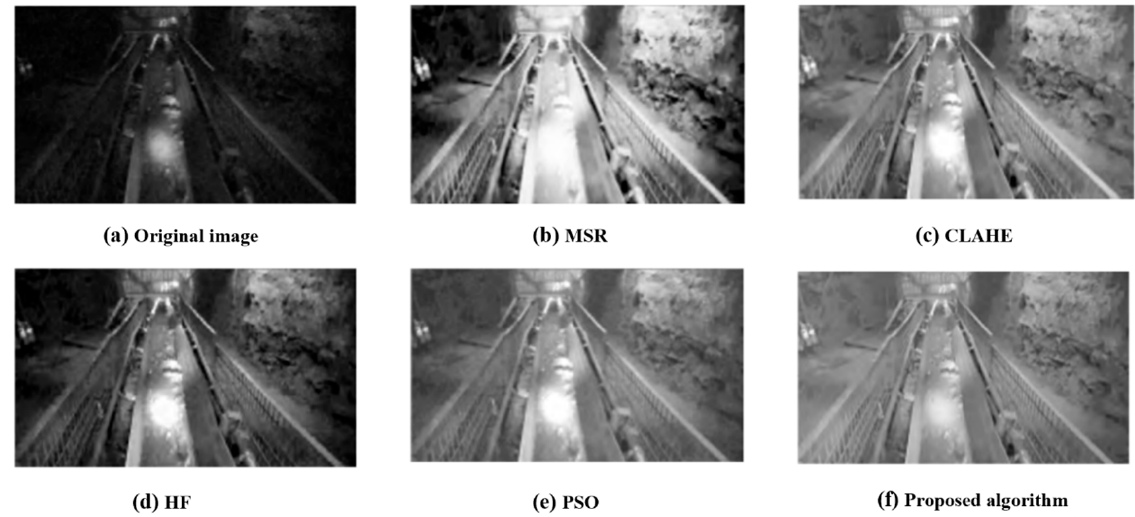
Figure 9. Comparison of mine video image enhancement effect.